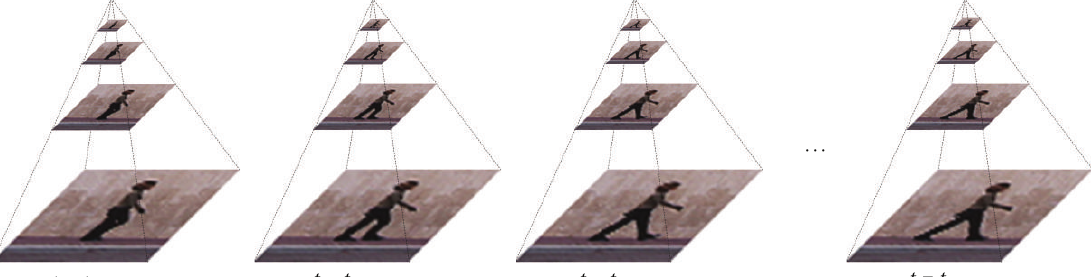
Figure 8: Motion sequence pyramid 𝑓(𝑖,𝑗, 𝑡) .